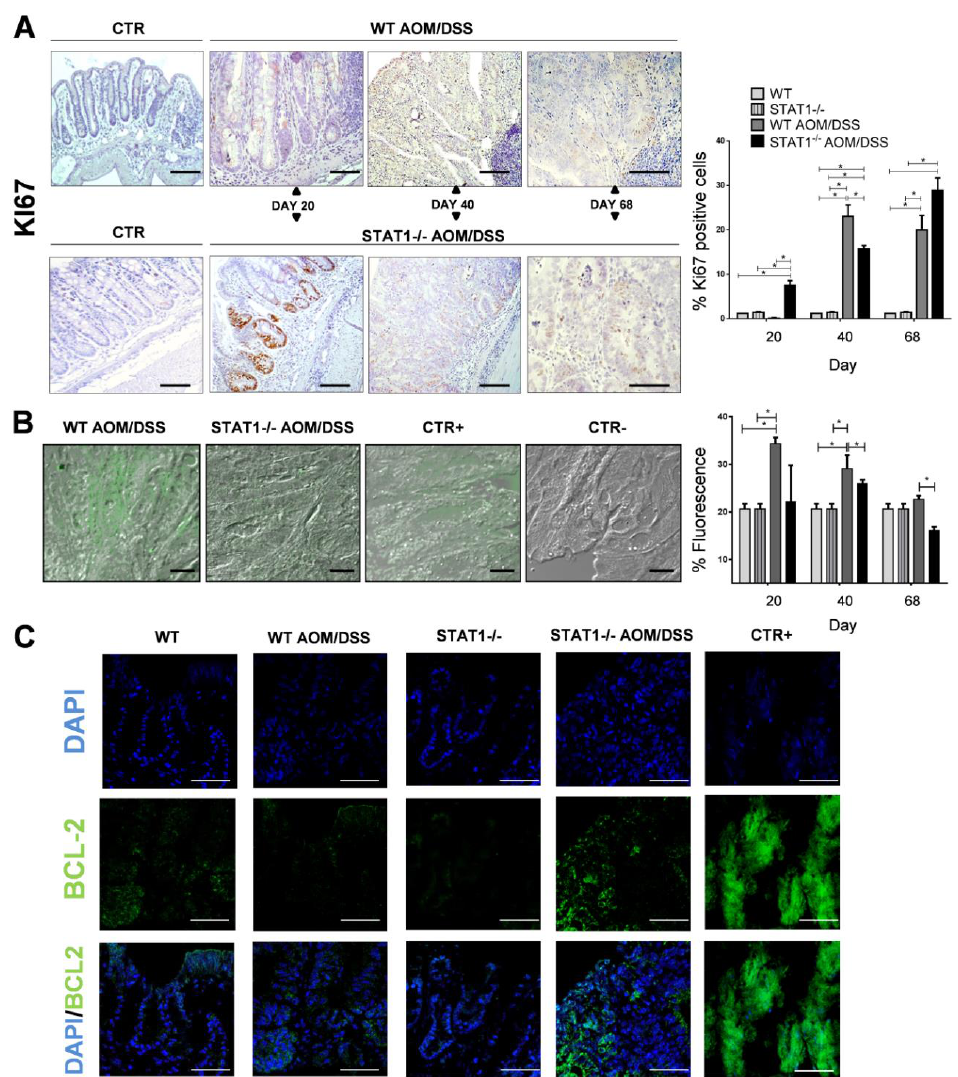
Figure 5. Enhanced colon epithelial cell proliferation and reduced apoptosis in STAT1 − / − mice during CAC development. Distal/affected colons were obtained from WT and STAT1 − / − AOM/DSS-treated or control mice at the indicated time intervals. ( A ) Representative Ki67 immunohistochemistry (left) in WT and STAT1 − / − mice given AOM/DSS or control groups. Scale bars: 50 µm. Ki67 + cells were quantified using ImageJ software v.1.48 by counting cells in 10 high-powered fields in at least three slides per animal (right). ( B ) Apoptotic cells in distal colons from WT and STAT1 − / − control and AOM/DSS treated mice were monitored by an in situ cell death assay in which cleavage of genomic DNA during apoptosis yields double strand as well as single strand breaks (nicks), and then were identified by labeling free 3′ -OH terminal with fluorescein. Representative images at 20 days after AOM injections are shown (left). Scale bars: 20 µm. The positive control was treated with DNase enzyme, while in the negative control; the cells were incubated with label solution only. Data are presented as the percentage of mean fluorescence, which was expressed as arbitrary units (right). ( C ) Representative images of immunofluorescence staining of Bcl-2 in the distal/affected colon tissue of the indicated experimental groups. The thymus was used as a positive control. Scale bars: 20 µm. Data are expressed as mean ± SEM and are representative of two independent experiments with at least 3 mice per group per day of the analysis. * p < 0.05, ** p < 0.01.